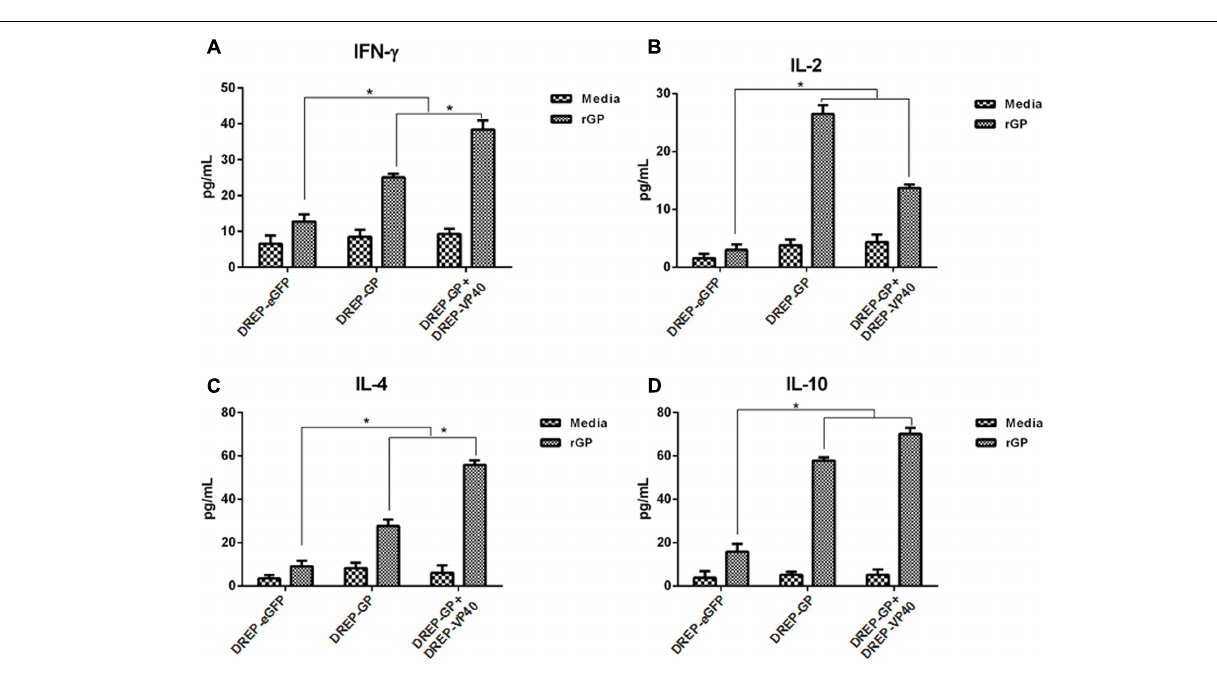
( Figure 3C ). However, there was no significant difference in the induction of anti-VP40 antibody subtypes between the DREP- GP + DREP-VP40 and DREP-VP40 vectors. The above